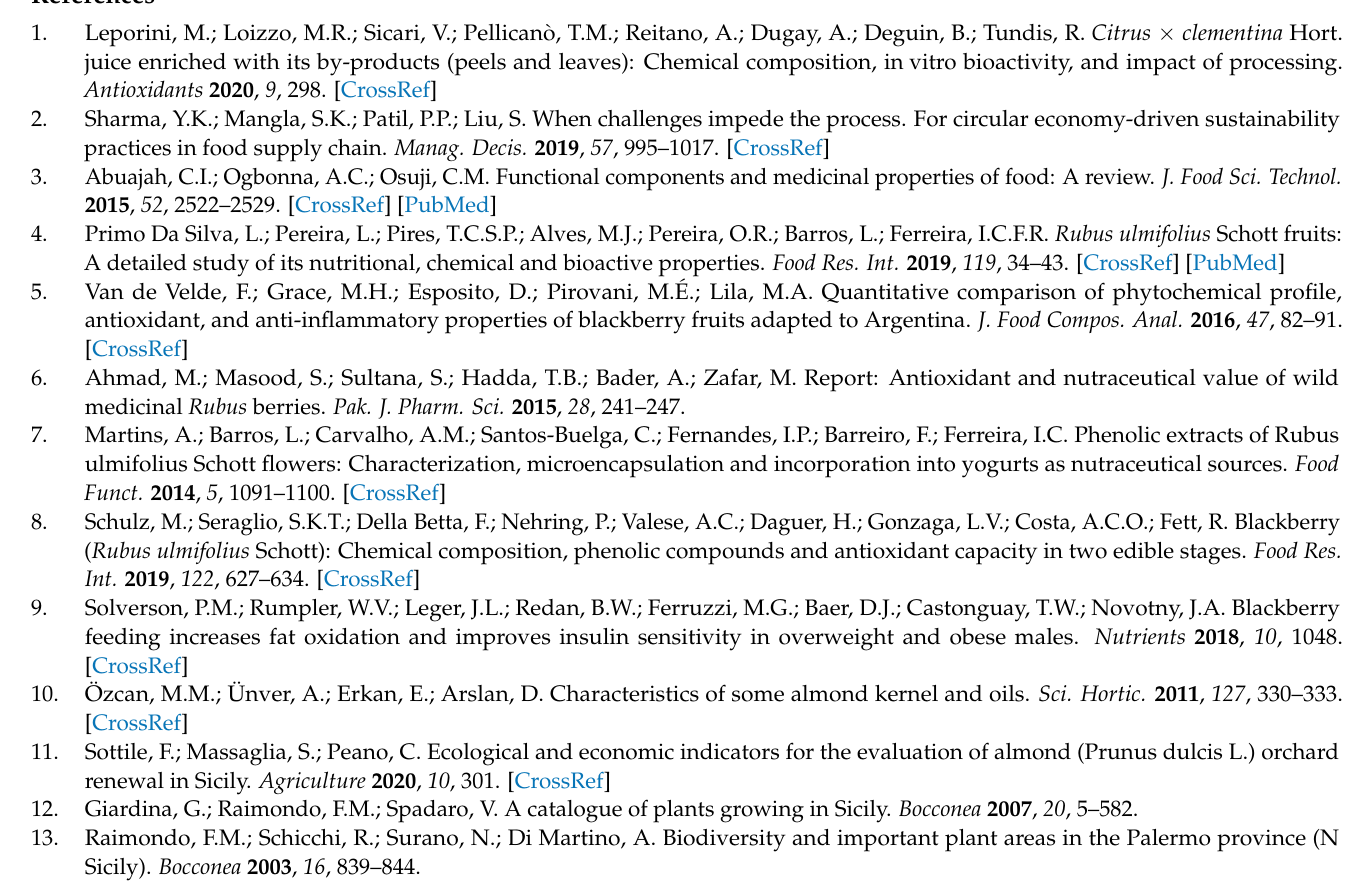
almond skin extract. Table S2. Secondary metabolites identified in ethanol extract of blackberry fruits (EB) and in ethanol extract of almond skin (ET) by LC-ESI/LTQOrbitrap/MS/MSn analysis, operating in positive and negative ion mode. Table S3. Sensory analysis of pasteurised enriched jam. Figure S1. Phytochemicals content in enriched jam (a) and pasteurised enriched jam (b). Figure S2. Sensory profile of enriched